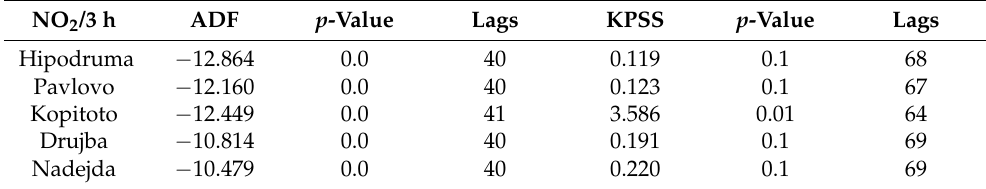
Table 7. Values of the ADF and KPSS tests applied on the NO 2 dataset for granularities: 3 h.